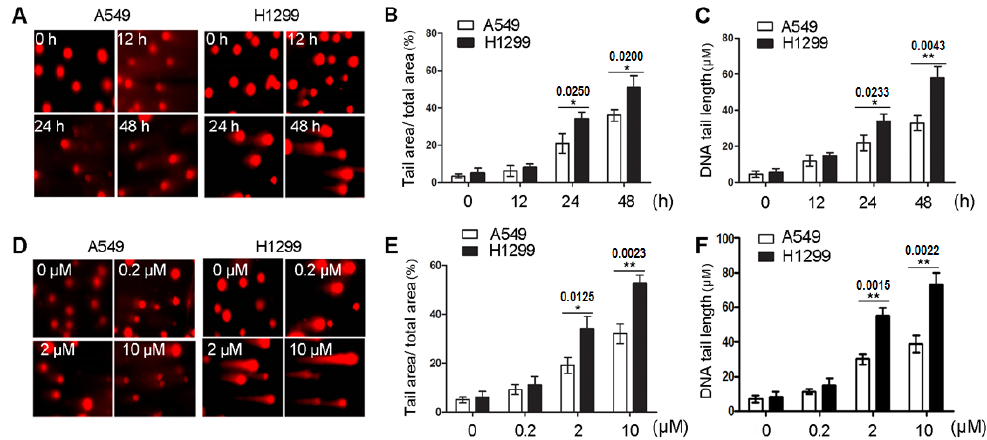
Figure 3. Comet assays for 8-Cl-Ado-induced double-strand breaks (DSBs). ( A ) A typical representation of time-dependent comet assays. A549 and H1299 cells were exposed to 2 μ M 8-Cl-Ado for indicated hours. DSBs were evaluated by the percentage of DNA tail area in whole DNA area ( B ) and by comet tail length ( C ); ( D ) a representative dose-dependent comet assays. Cells were exposed to increased 8-Cl-Ado for 48 h; ( E ) the percentage of DNA tail area in whole DNA area; and ( F ) the comet tail length. Data represent mean ± SD ( n = 3). The percentage of comet tail area and tail length was analyzed in at least 50 cells each slide. * p < 0.05; ** p < 0.01.